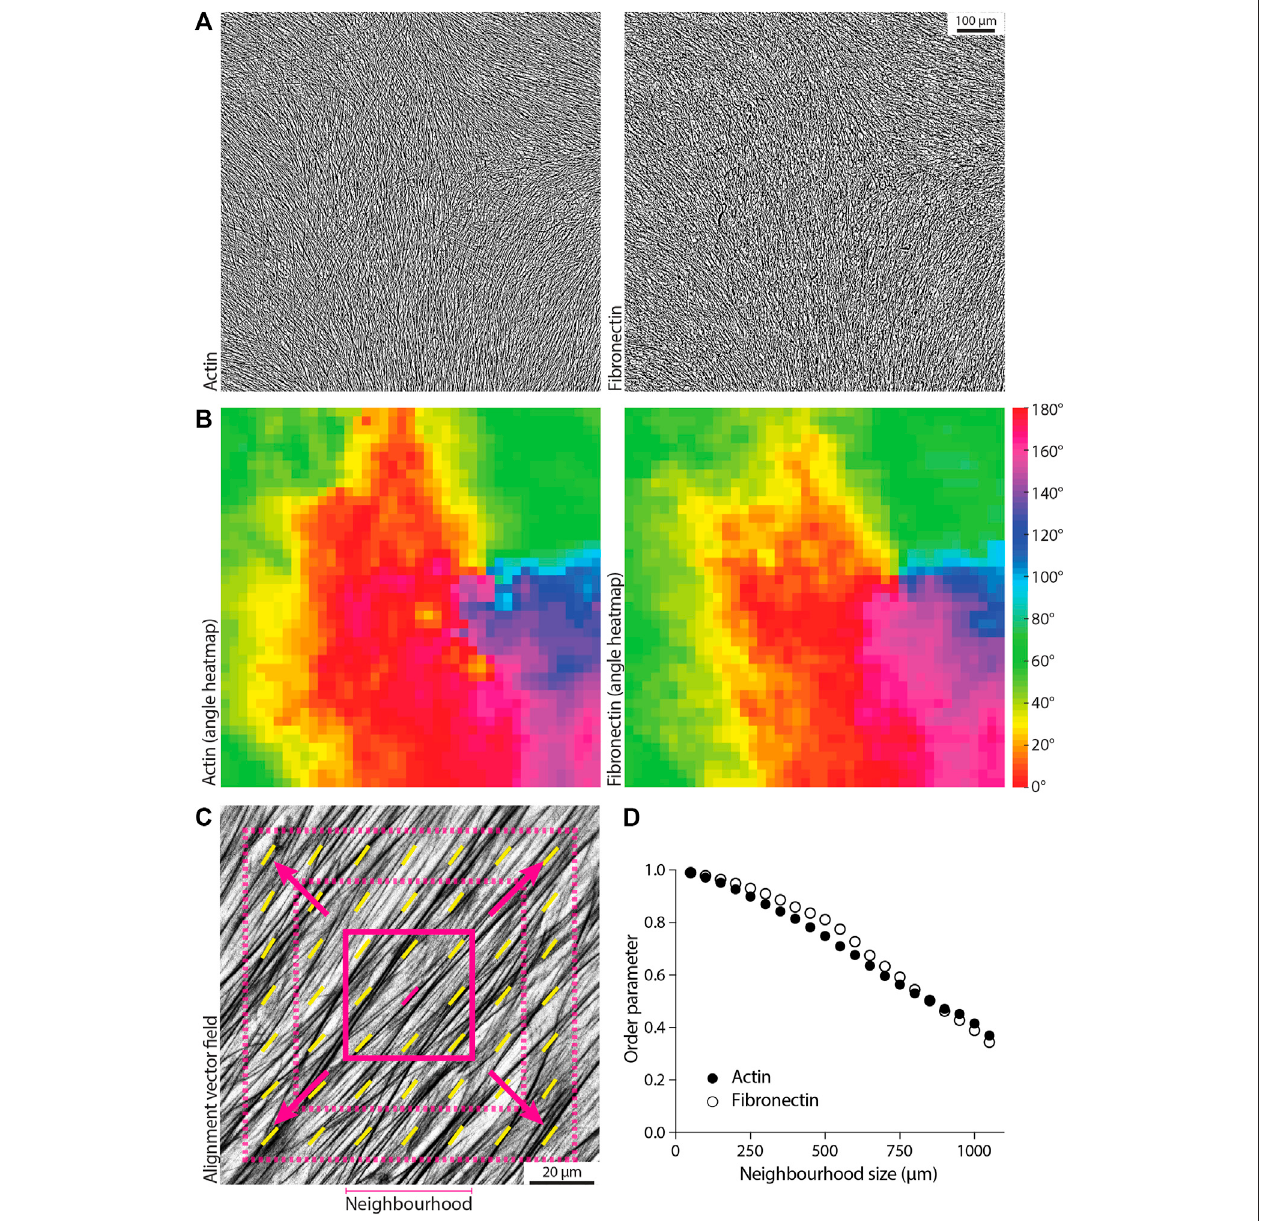
FIGURE 6| Measuring the decay in order parameter as afunction oflength scale. (A) Example tilescan images about 1 mm 2 in size for actin and fi bronectinon the same sample ( fi broblast-derived matrix). Scale bar, 100 μ m . (B) Angle heatmap showing the alignment vector fi eld for the images in (A) , using a window size of 250 px and 50 % overlap. Actin and fi bronectin display similar alignment. (C) Schematic of the alignment decay analysis, where the window size is maintained constant while increasing the size of the neighborhood (i.e., including more and more vectors in the order parameter calculation to evaluate alignment from the local to the global scale). The solid magenta square represents the starting neighborhood, which then increases in size at each iteration (dashed magenta squares). (D) The calculated order parameter for actin and fi bronectin for the images in (A) is graphed for a window size of 250 px , for each neighborhood ranging from 50 μ m (3 x vectors, neighborhood radius of 1 x vector) to 1050 μ m (43 x vectors, neighborhood radius of 21 x vectors). Alignment decays in a similar manner when going from local (small neighborhood size) to global (large neighborhood size) length scales.